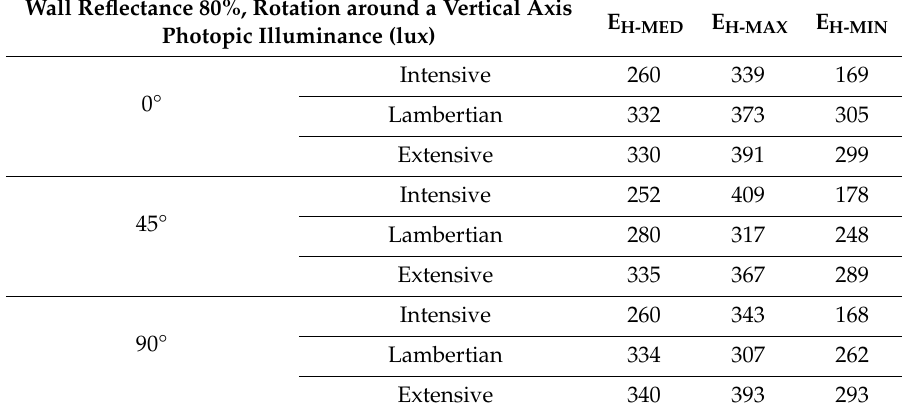
Figure 5. Graphical representation of the angular variation of the vision axis with respect to the vertical axis; vertical illuminance at the eye-level plane (120 cm); wall reflectance 80%. Table 4. Relationship between the vertical illuminance at the eye-level plane (120 cm), 80% reflectance, and angular variation in the vertical axis.